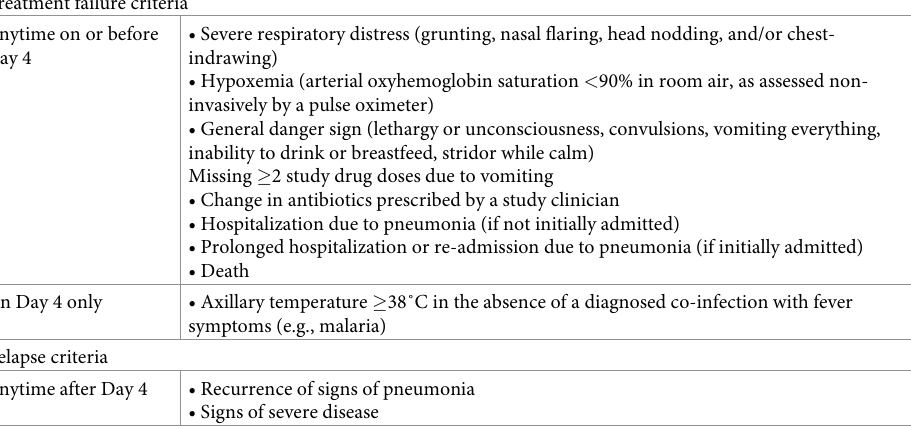
Table 2. Treatment failure and relapse